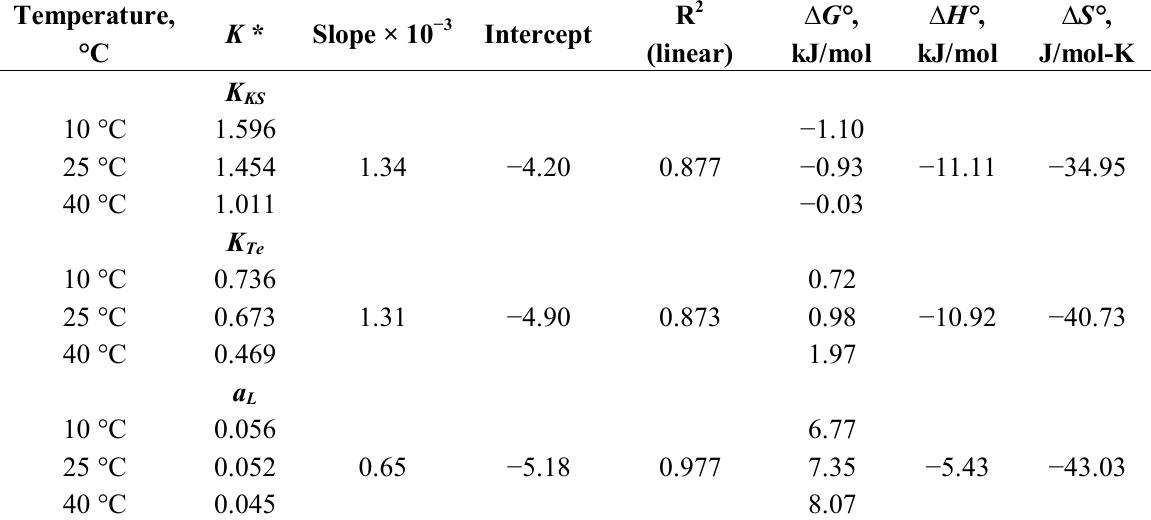
Table 4. Comparison of thermodynamic parameters for adsorption of ammonia on